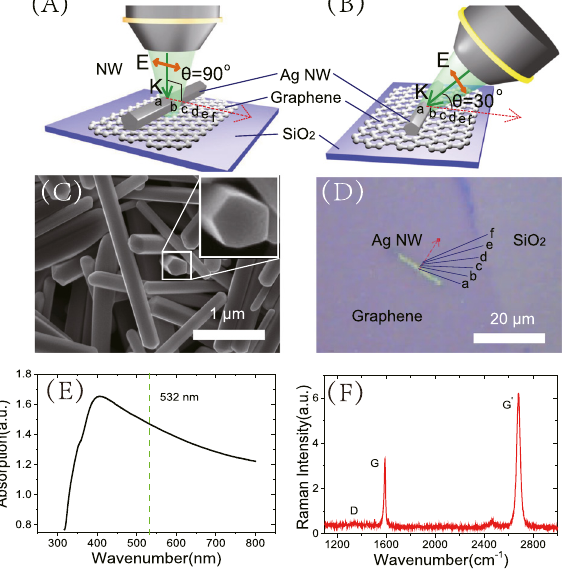
Figure 2: (A) Surface-enhanced Raman scattering (SERS) spectra of a single-layer graphene (SLG) in the graphene/SiO 2 fi lm-coupled nanowire(NW)hybridnanogapbyobliqueincidencewith θ =30 ° (as shown in Figure 1(B)) at difference points away from the center of axis of the NW. (B) The Raman intensities of D , G, and G ′ SERS peaks showninA;(C)TheRamanshiftsof D , G, and G ′ SERSpeaksshownin A; (D) The SERS spectra of SLG in the graphene/SiO 2 fi lm-coupled NW hybrid nanogap by normal incidence with θ = 90 ° (as shown in Figure 1(A)) at difference points away from the center of axis of the NW.(E)TheRamanintensitiesof D , G, and G ′ SERSpeaksshowninD; (F) The Raman shifts of D , G, and G ′ SERS peaks shown in the NW and the SLG contacting surface. Here, the SLG was